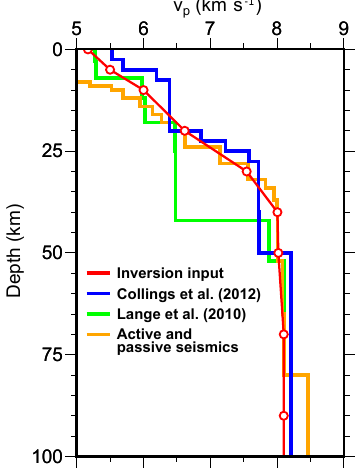
Figure 3. Velocity models used as starting model for the two- dimensional tomographic inversion of v p (red line and red circles). Because of the large number of stations and events on or near the SFZ, the minimum 1-D velocity model (green line) is dominated by the crustal structure of the Sumatran mainland. This velocity model is not appropriate for the events in the outer forearc, so we constructed a layered 1-D v p velocity function based on an ac- tive source refraction study (Vermeesch et al., 2009). Above 30km depth, we adopted a one-dimensional, staircase-like velocity–depth function based on an active source refraction study (Vermeesch et al., 2009, orange line); for depths greater than 30km we adopted the one-dimensional velocity function from a minimum 1-D veloc- ity model (Lange et al., 2010). The blue line shows the minimum 1-D v p velocity model from Collings et al. (2012) for the region adjacent to the southeast of our study region but covering a similar part of the subduction